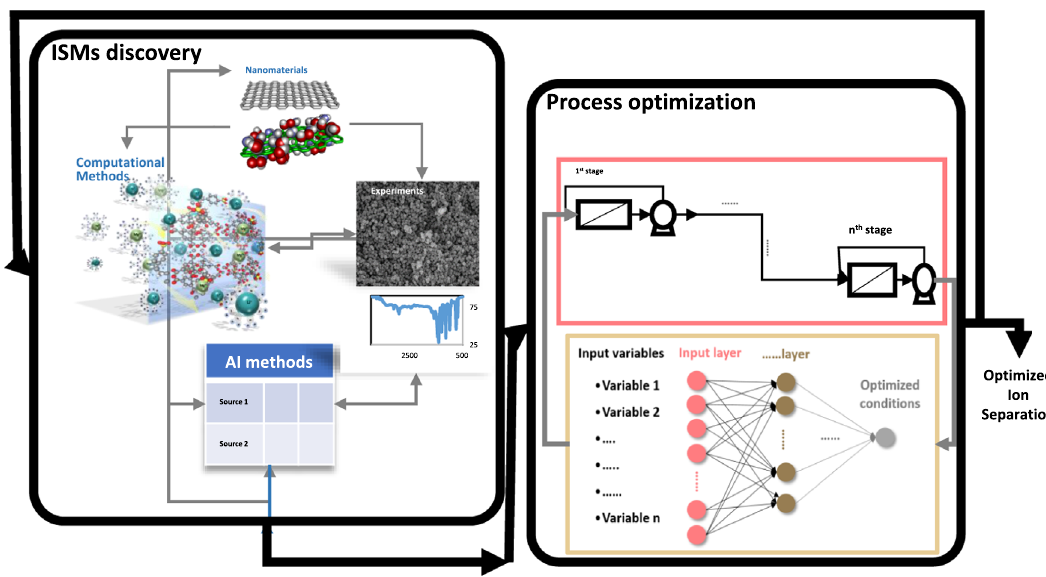
Fig. 1 Schematic representation of the application of AI methods for the discovery and design of new ISMs. AI can optimize current ISMs or suggest new ISMs based on computational (or experimental) data. Optimization and discovery of new materials in this method are based on a model that AI builds from related computational (or experimental) datasets. Based on this model, AI can determine the optimal conditions for ion separation (including ISMs